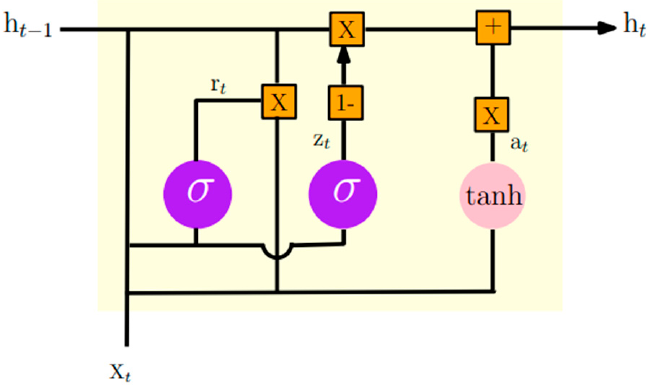
Figure A3. The basic structure of GRU [57].